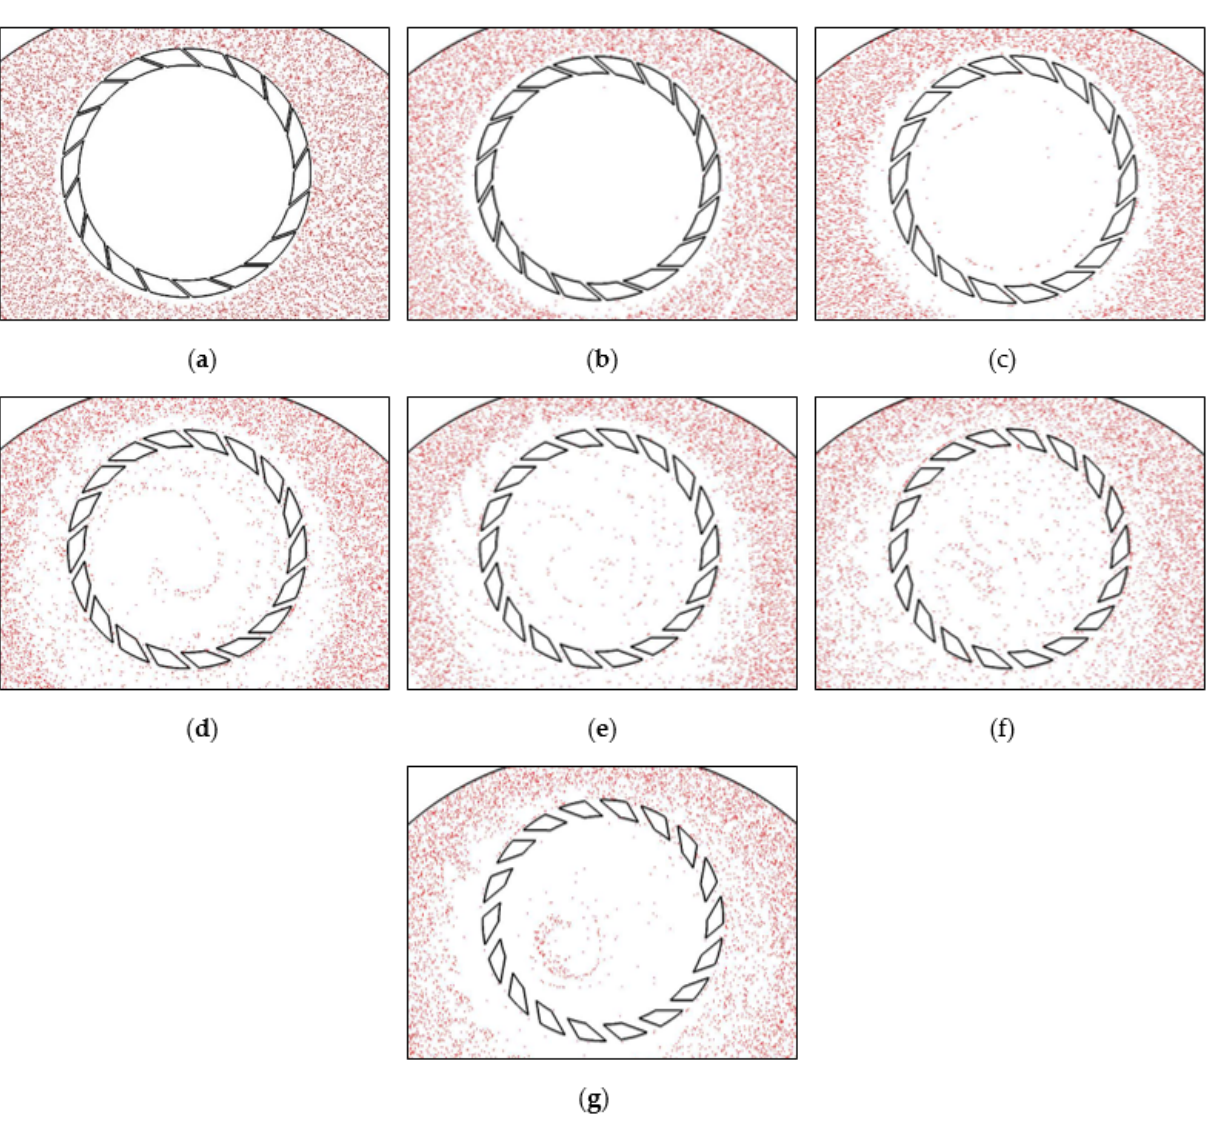
Figure 8. Abrasive distribution nephogram in polishing gap with different groove widths: ( a ) 3 mm, ( b ) 5 mm, ( c ) 7 mm, ( d ) 9 mm, ( e ) 11 mm, ( f ) 13 mm, ( g ) 15 mm .